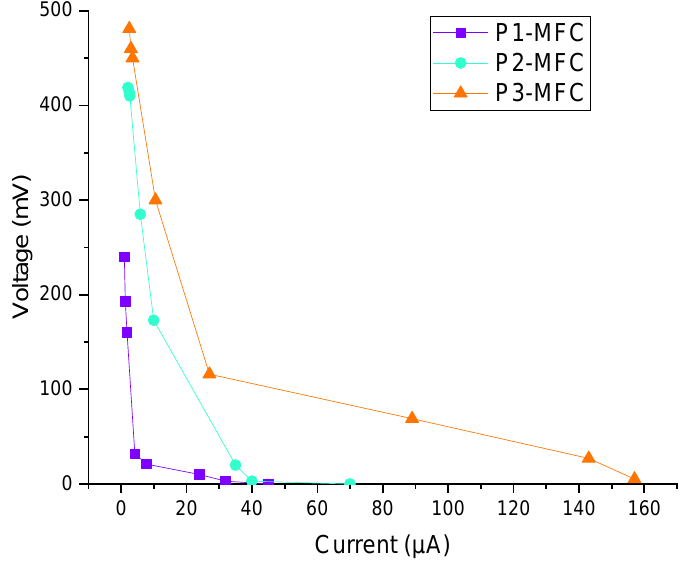
Figure 2. Polarization curves of MFCs.